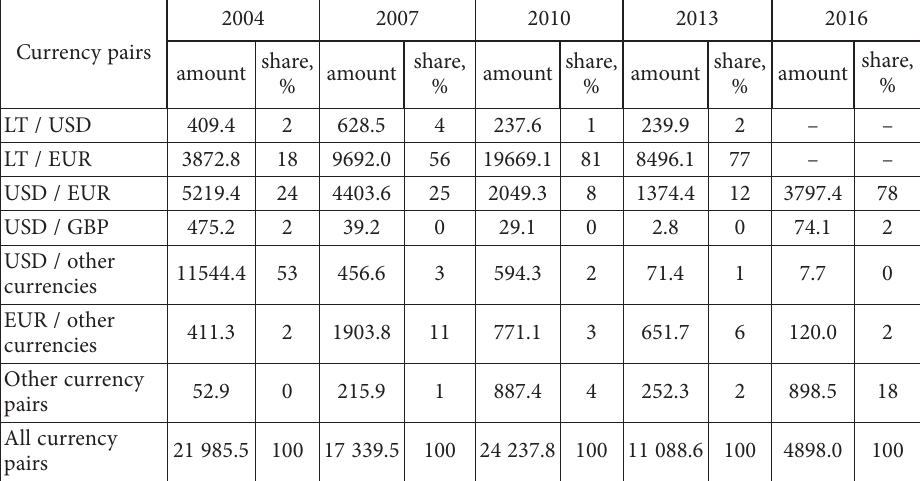
Table 2. Turnover in the Lithuanian foreign exchange market by currency pairs (nominal or notional amounts in 2016; millions of U.S. dollars) (source: LB, 2016, 2018; BIS, 2018a)